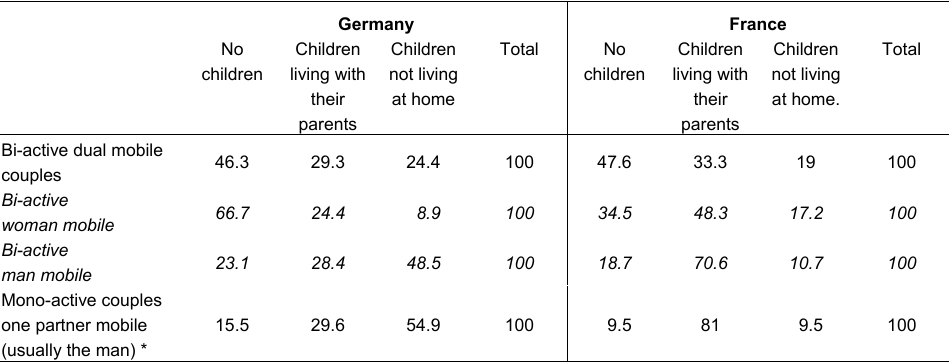
Table 3 : Couples’ mobility situation and presence of children in daily life